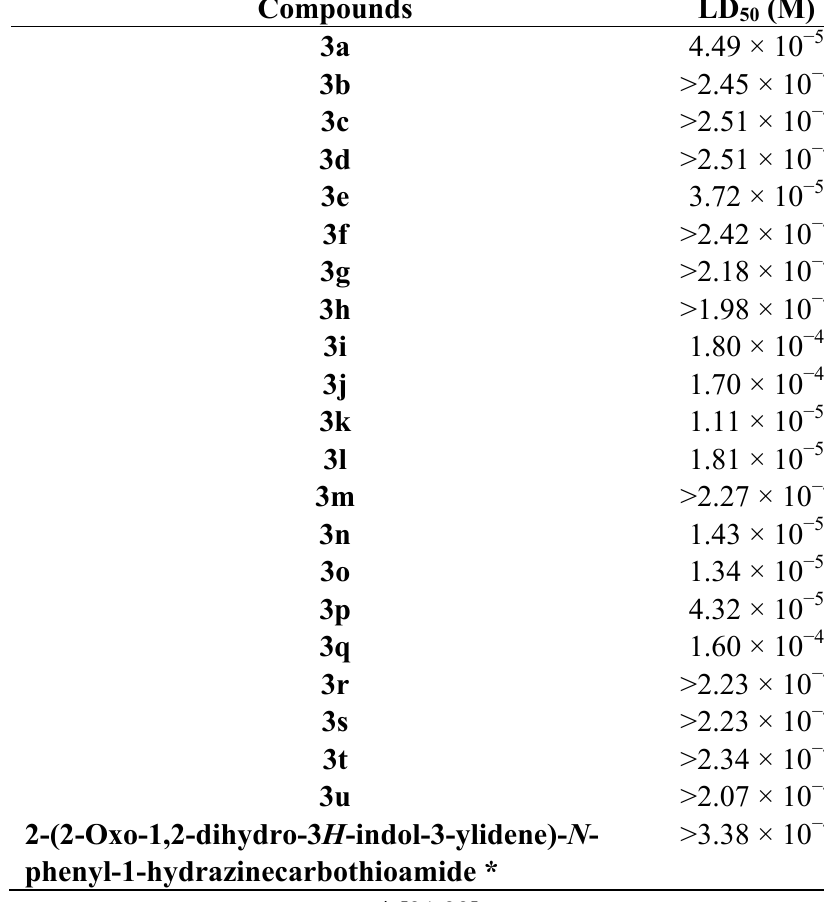
Table. Brine shrimp ( Artemia salina ) bioassay of compounds 3a-3u